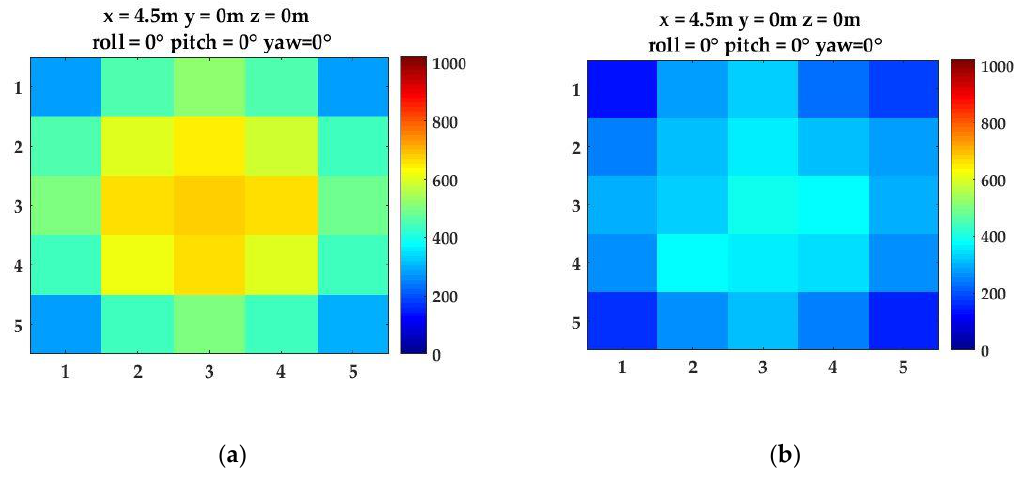
Figure 12. The sampled light field in the simulator in two different water clarity conditions at the same distance to the light source: ( a ) image sampled in relatively clear waters with 𝐾 𝐷 = 0.09 m −1 ; and ( b ) image sampled in turbid waters with 𝐾 𝐷 = 0.2 m −1 .